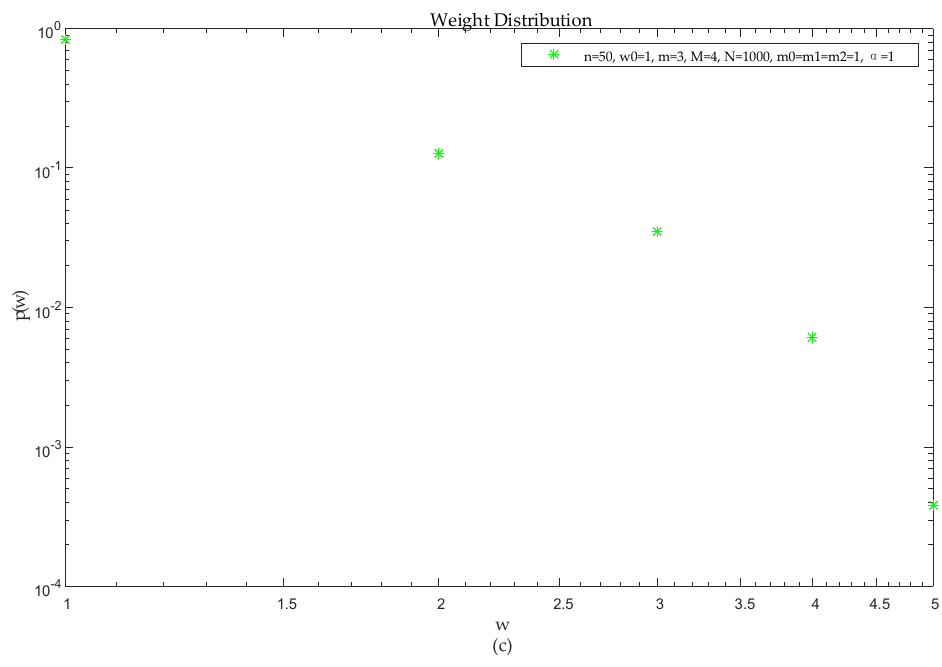
Figure 4. Space information network characteristics analysis at the initial moment: ( a ) Distribution of node strength; ( b ) Distribution of node degree; ( c ) Distribution of edge weights.